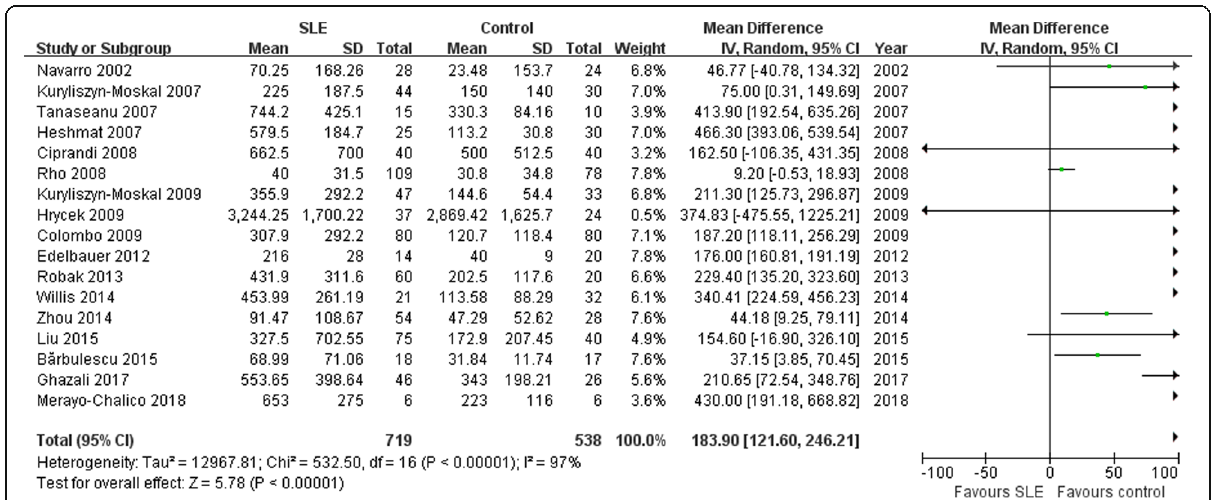
Fig. 1 Association of vascular endothelial growth factor protein levels with SLE risk. SLE: systemic lupus erythematosus; SD: standard deviation; Total: the total number of SLE group or control group; CI: confidence intervals; I 2 : test the heterogeneity among recruited studies; df: degrees of